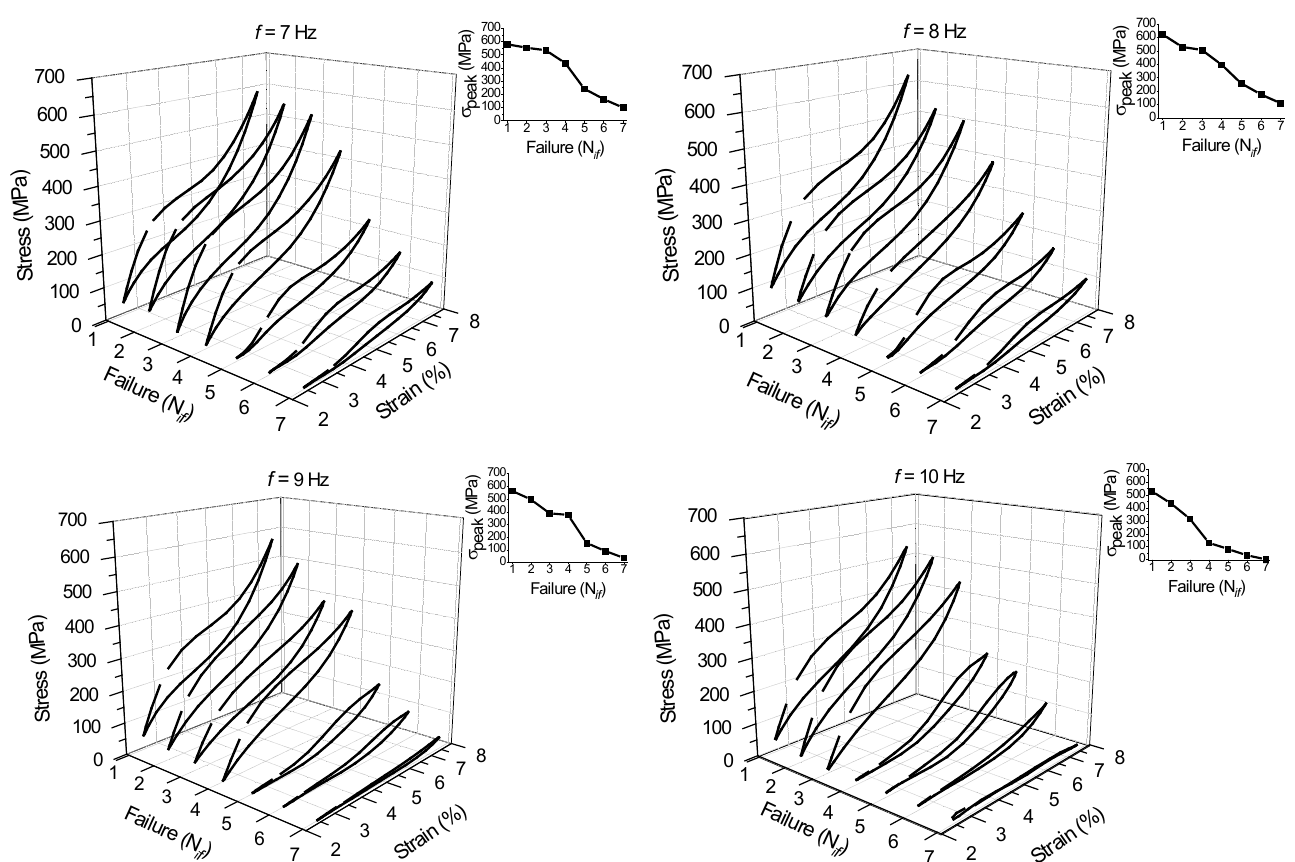
Figure 15. Stress vs. strain superelastic response immediately prior to the failure of the filaments of the SMA NiTi micro cable from 1 Hz to 6 Hz.